Question: What kind of plot is shown here?
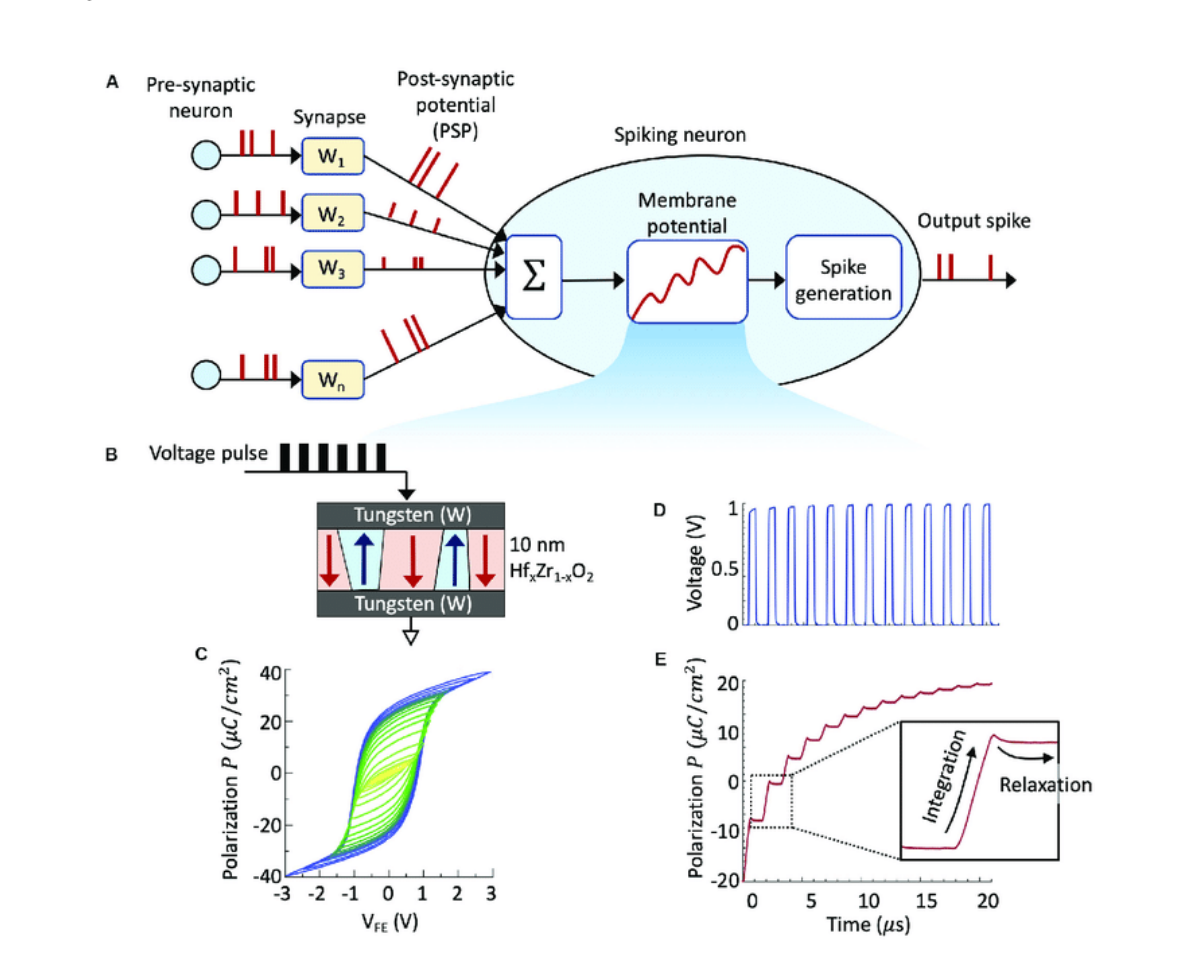
Answer: line